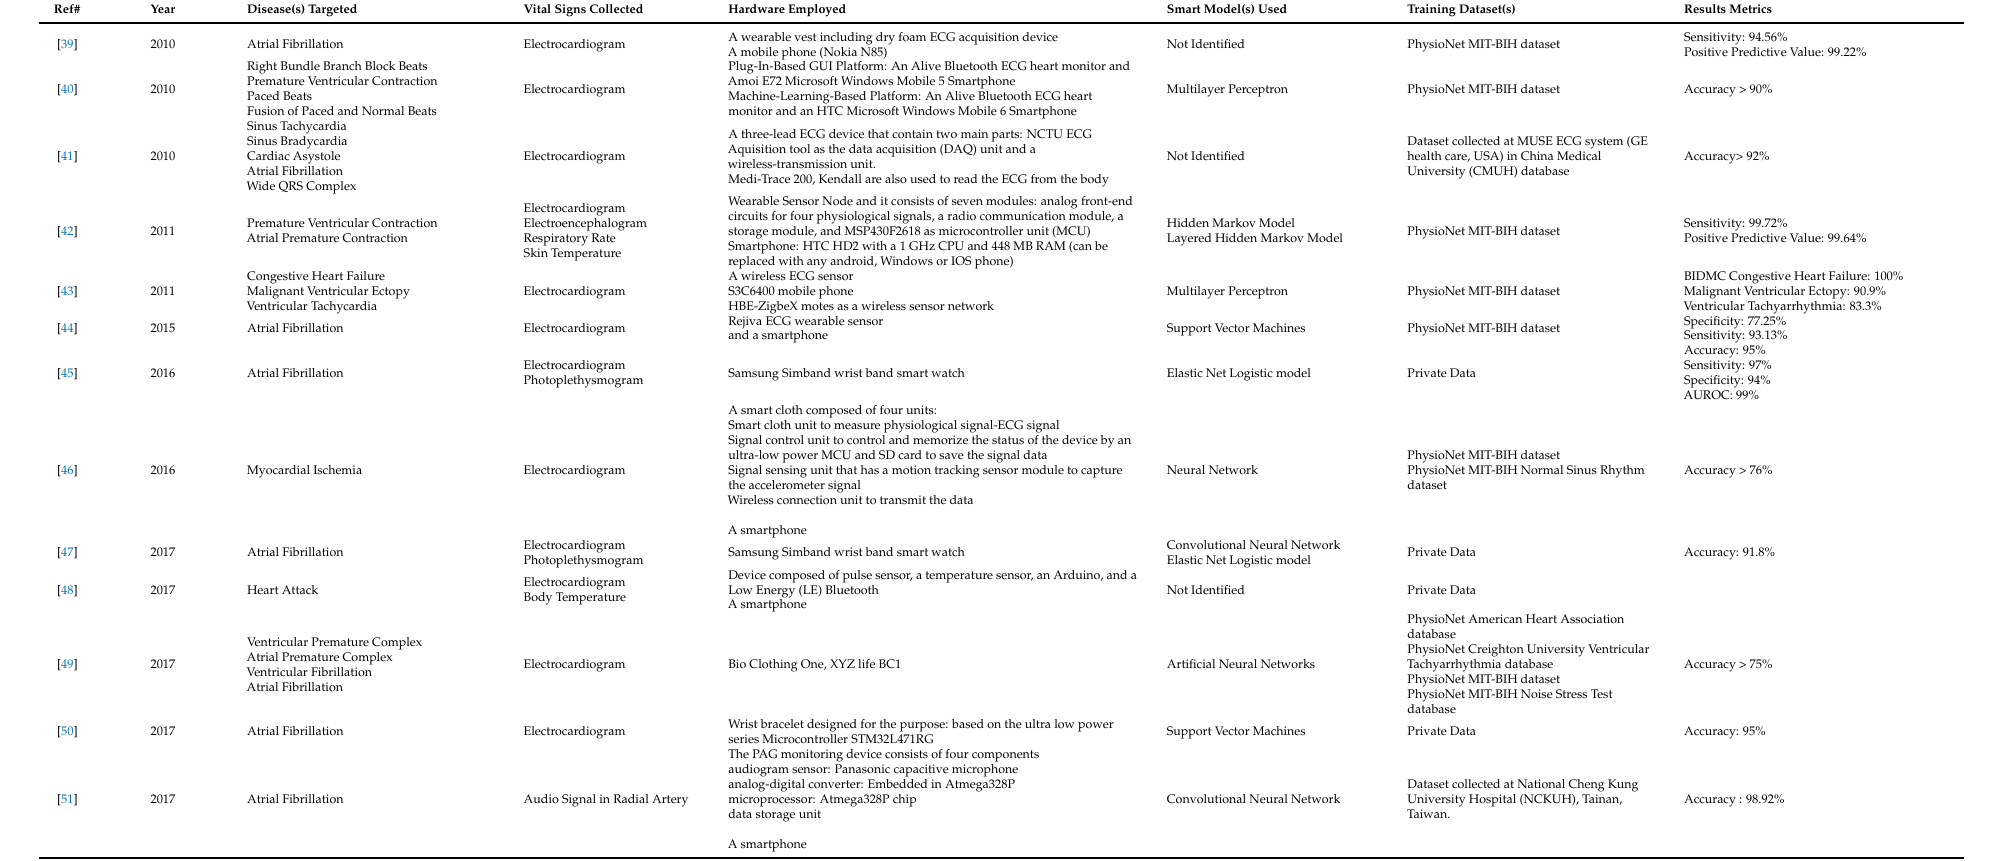
Table 2. Implementations of smart wearables in detection of